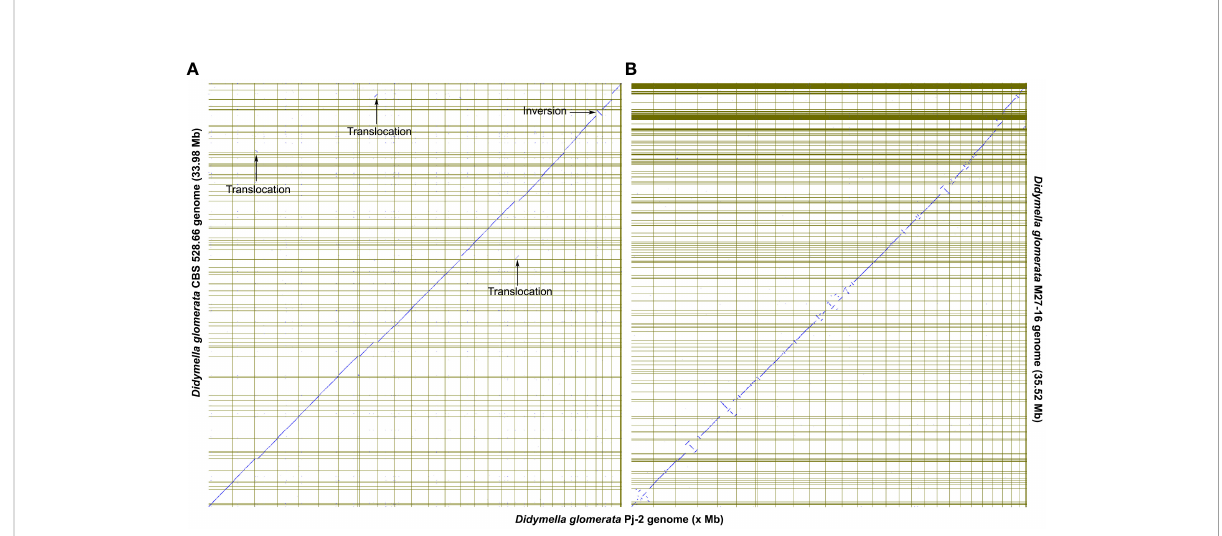
FIGURE 3 The dot plots show the collinearity of the D. glomerata Pj-2 genome (X-axis) with that of CBS 528.66 (Y-axis; A ) and M27-16 (Y-axis; B ). Four translocations are conspicuously present between Pj-2 and CBS